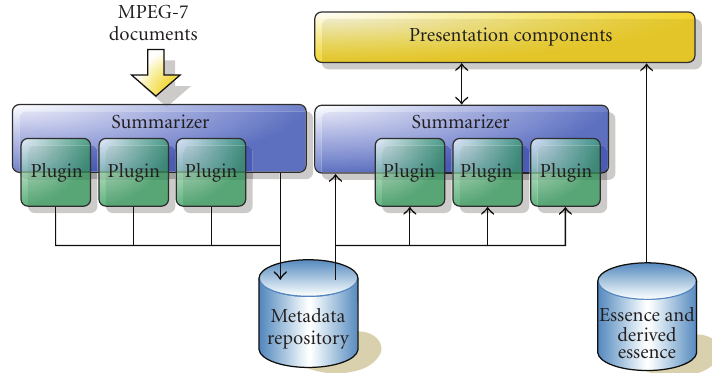
Figure 2: The components of the framework for video browsing.